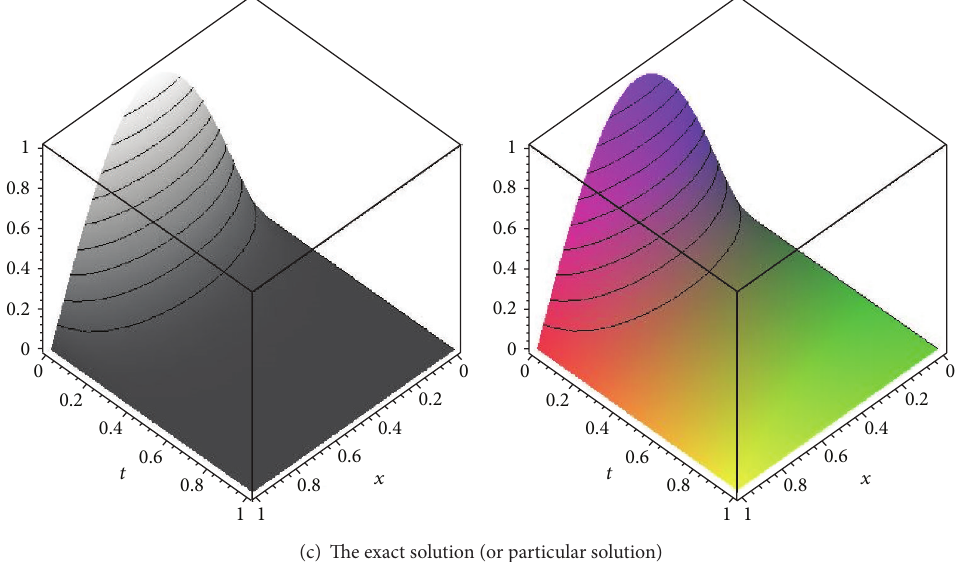
Figure 1: Simulation of approximate